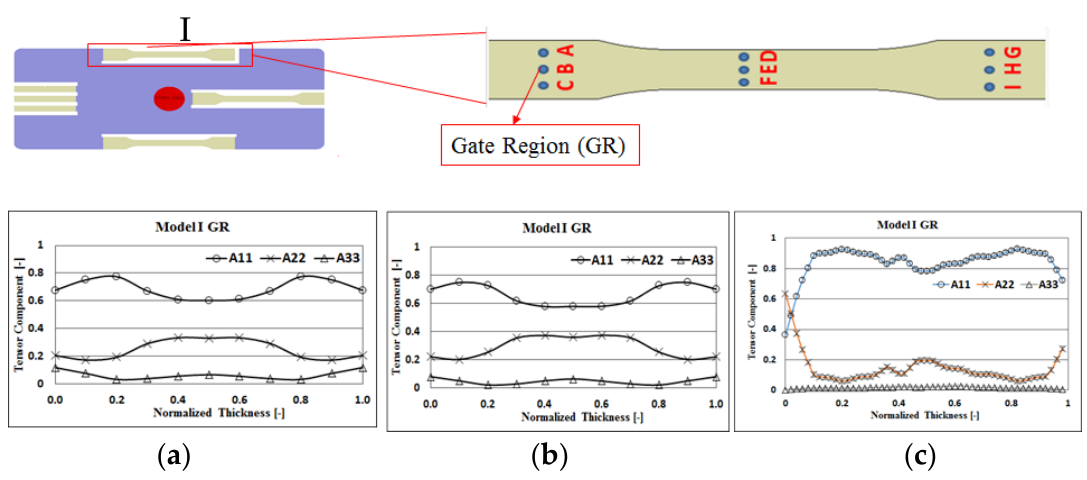
Figure 7. The comparison of the fiber orientation tensor components for Model I at Point B at GR: ( a ) simulation without flow–fiber coupling, ( b ) simulation with flow–fiber coupling, ( c ) experimental observation.